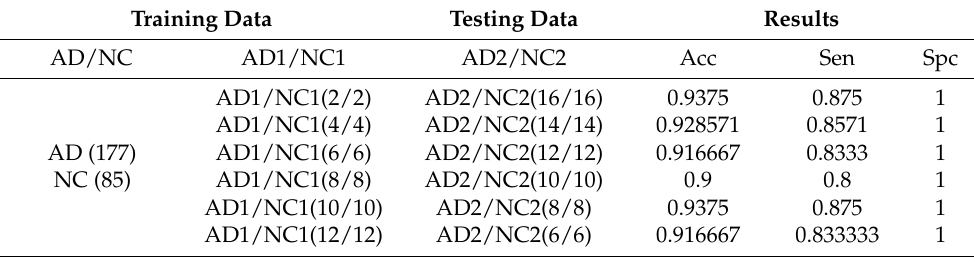
Table 8. Accuracy (ACC), Sensitivity (SEN), and Specificity (SPE)